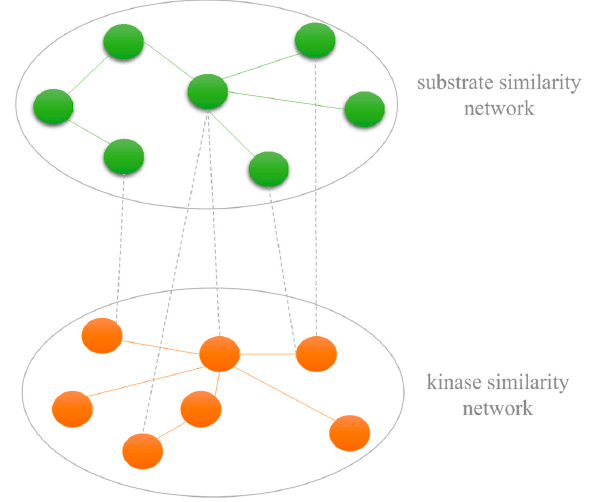
Figure 4. An example of the kinase–substrate heterogenous network.